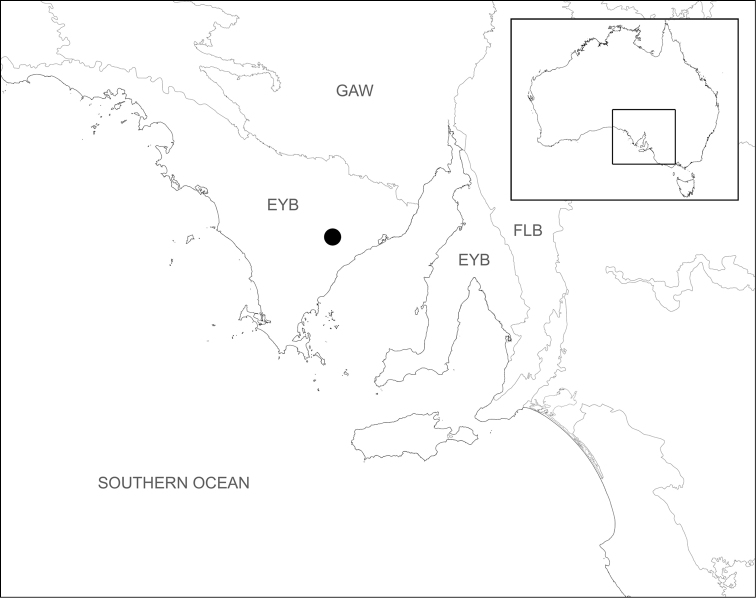
Map showing collection records of Idiosoma
corrugatum from the Eyre Peninsula of South Australia. Relevant IBRA 7.0 bioregions are as follows: EYB, Eyre Yorke Block; FLB, Flinders Lofty Block; GAW, Gawler.